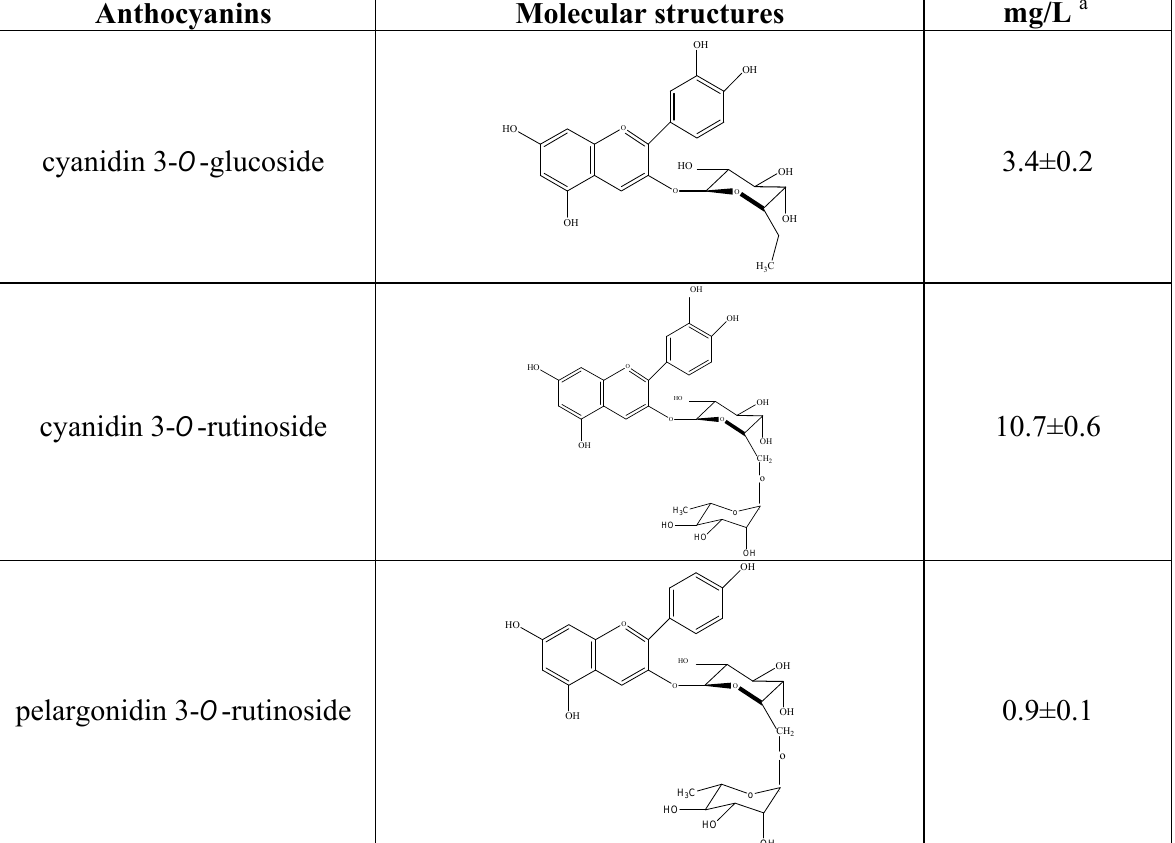
Table 3. Anthocyanin content in the microfiltrated water-extract of Delonix regia flowers. Anthocyanins Molecular